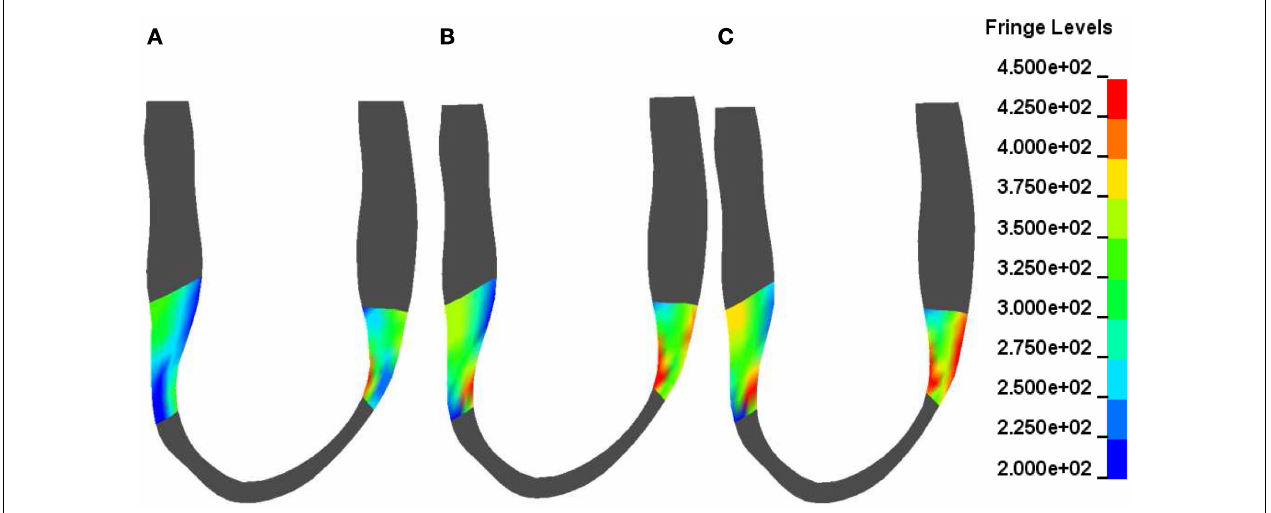
hPa = 0.1kPa = 0.1mN/mm 2 . Note the non-homogeneous BZ stress change after a 50 and 100% increase in BZ-contractility compared with the depressed BZ contractility.